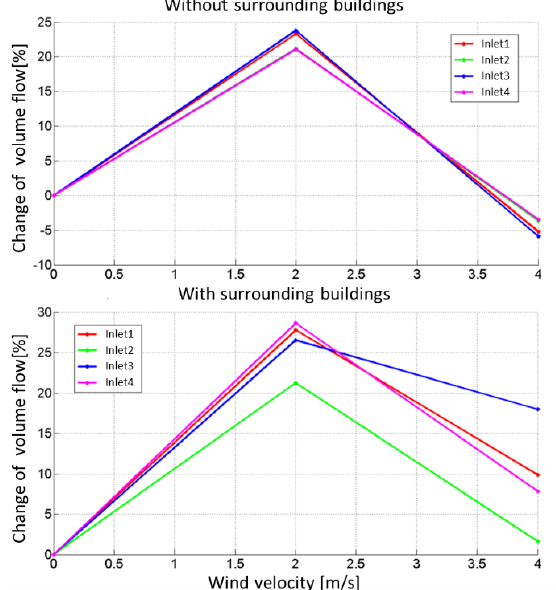
Fig. 10. Change of air volume flow with wind velocity Reason for decreasing the volume is the decrease of a pressure at ACC inlet.